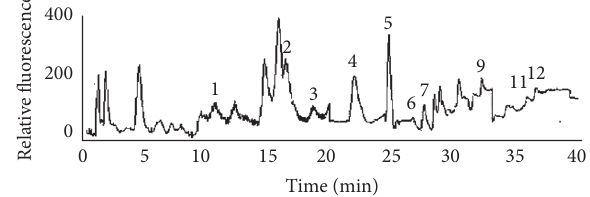
Figure 4: Chromatogram of a black tea sample: 1: naphthalene, 2: acenaphtene, 3: fluorene, 4: phenanthrene, 5: anthracene, 6: fluoranthene, 7: pyrene, 9: chrysene, 11: benzo[k]fluoranthene, and 12: benzo[a]pyrene. Chromatographic conditions as reported in Section